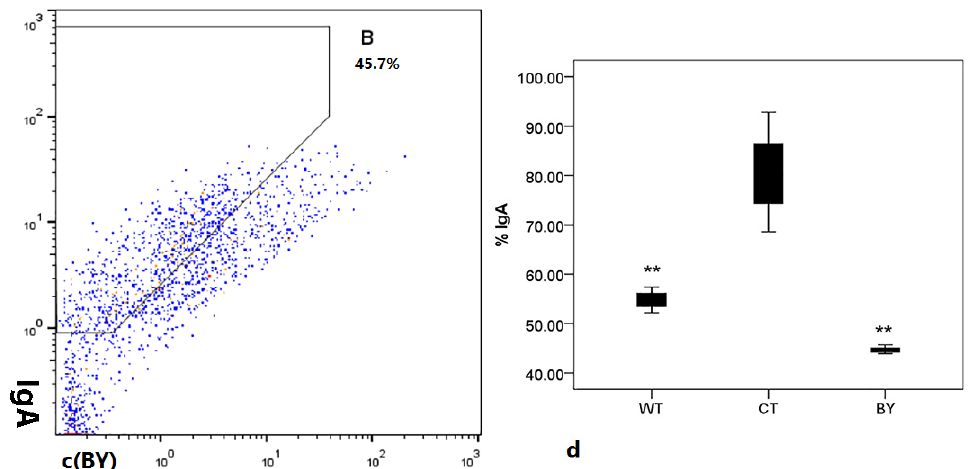
Figure 5. The IgA coating bacteria detected by the Flow Cytometry and the percent of IgA coating bacteria ( d ) in proximal colon contents in three groups of mice. Wild-type mice (( a ), WT), IL-10 − / − mice without treatment (( b ), CT), IL-10 − / − mice treated with butyrate (( c ), BY); Data are presented as mean ± SEM ( n = 4 for each group, * p < 0.05 and ** p < 0.01 versus CT group).